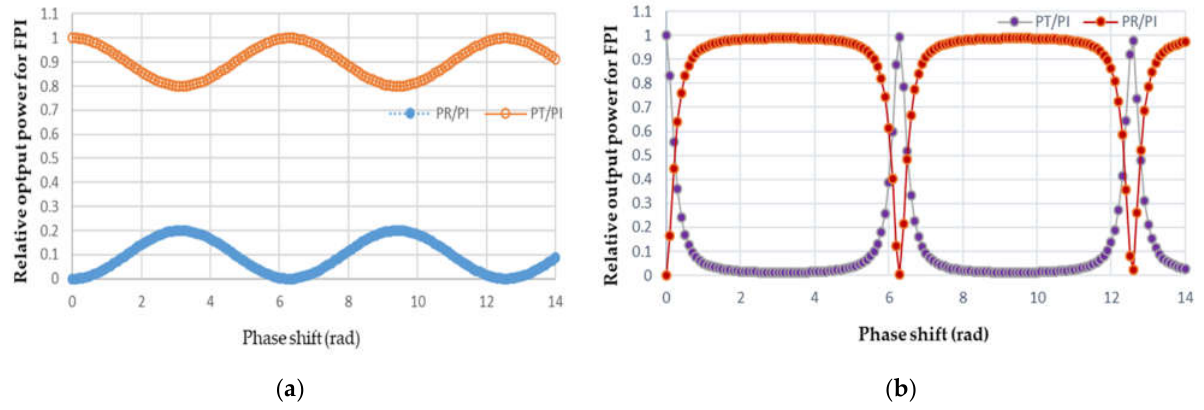
Figure 7. Relative output power vs. phase shift in the cavity of a single FFPI with a mirror reflectance of ( a ) R = 0.05 and ( b ) R = 0.8, assuming no optical loss.